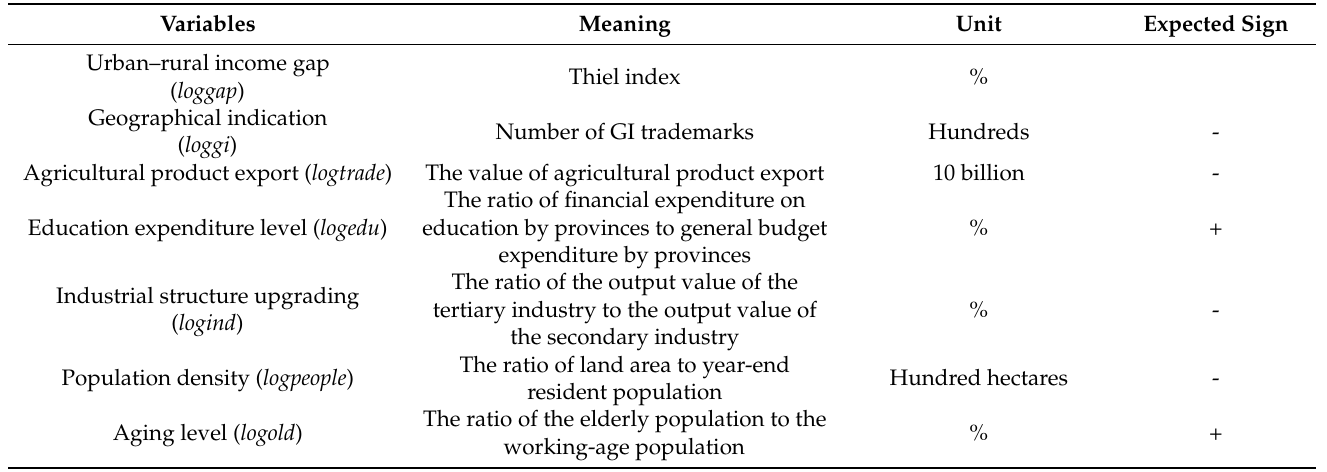
Table 1. Variable selection and indicator